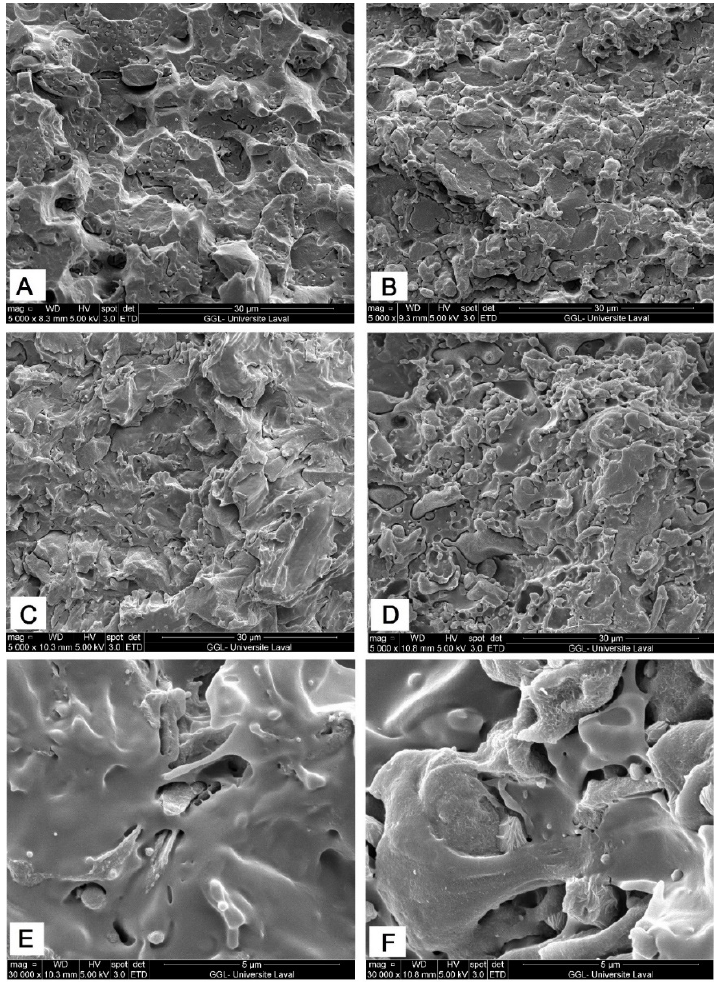
Figure 4. SEM micrographs of PA45/(PBAT10*) ( A , C , E ) and PA45(PEO10*) ( B , D , F ) ternary blends (see Section 3.2 for definition).